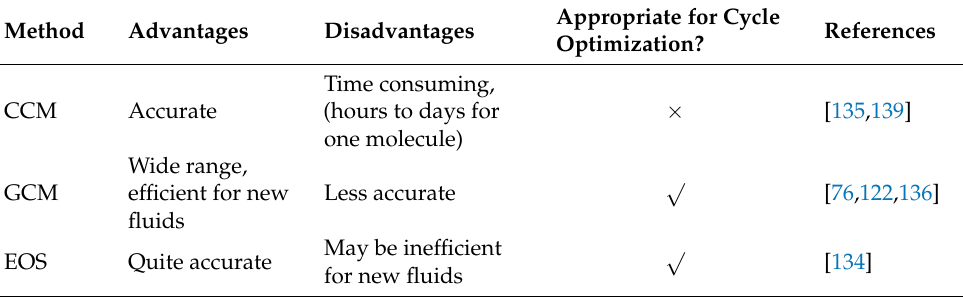
Table 7. Comparison of three computer-aided method for property